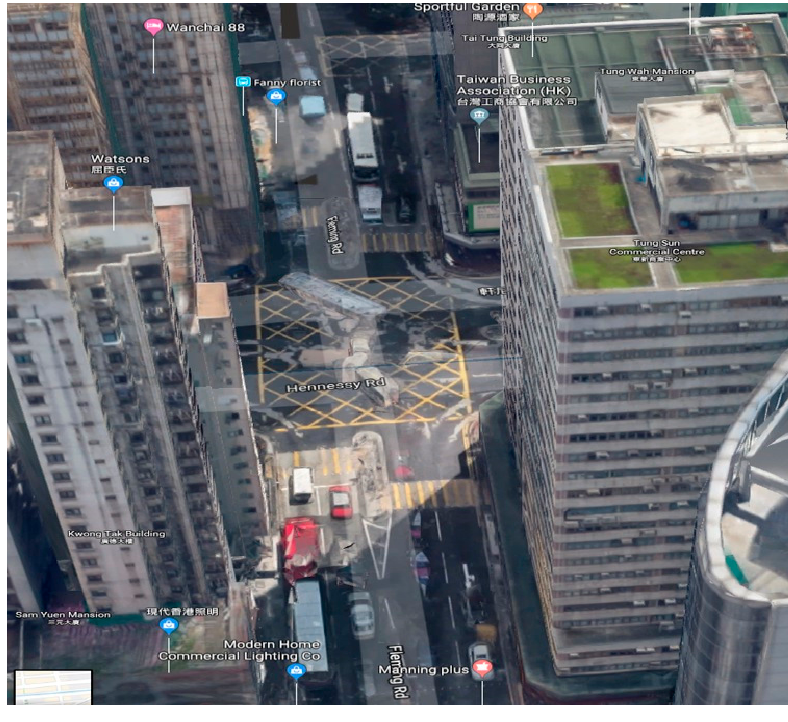
Figure 4. The case study 4-arm intersection with short lanes.